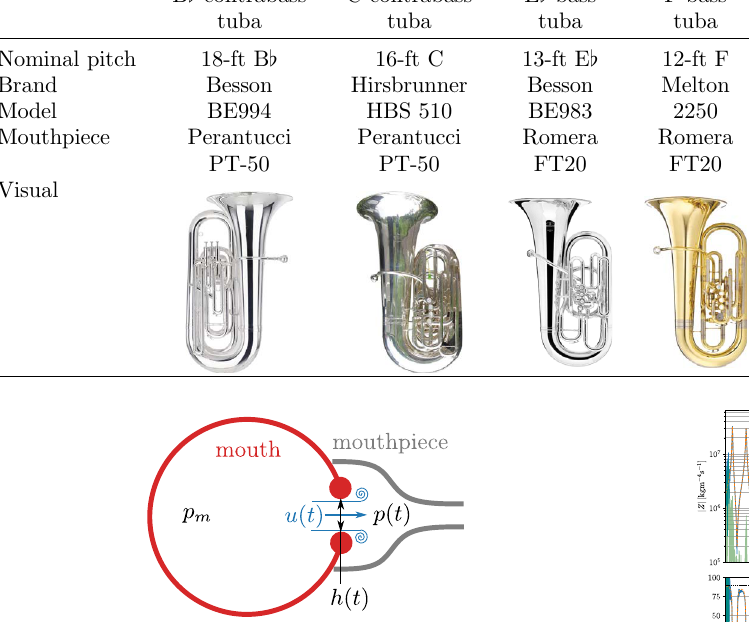
Figure 2. Schematic representation of the player ’ s mouth coupled to the mouthpiece of a brass instrument. p m stands for the blowing mouth pressure, u ( t ) is the volume velocity fl owing from the player ’ s mouth into the mouthpiece, p ( t ) is the acoustic pressure inside the mouthpiece, and h ( t ) is the height between the lips. Table 2. Lips ’ parameters used throughout the article, taken from Mattéoli et al.